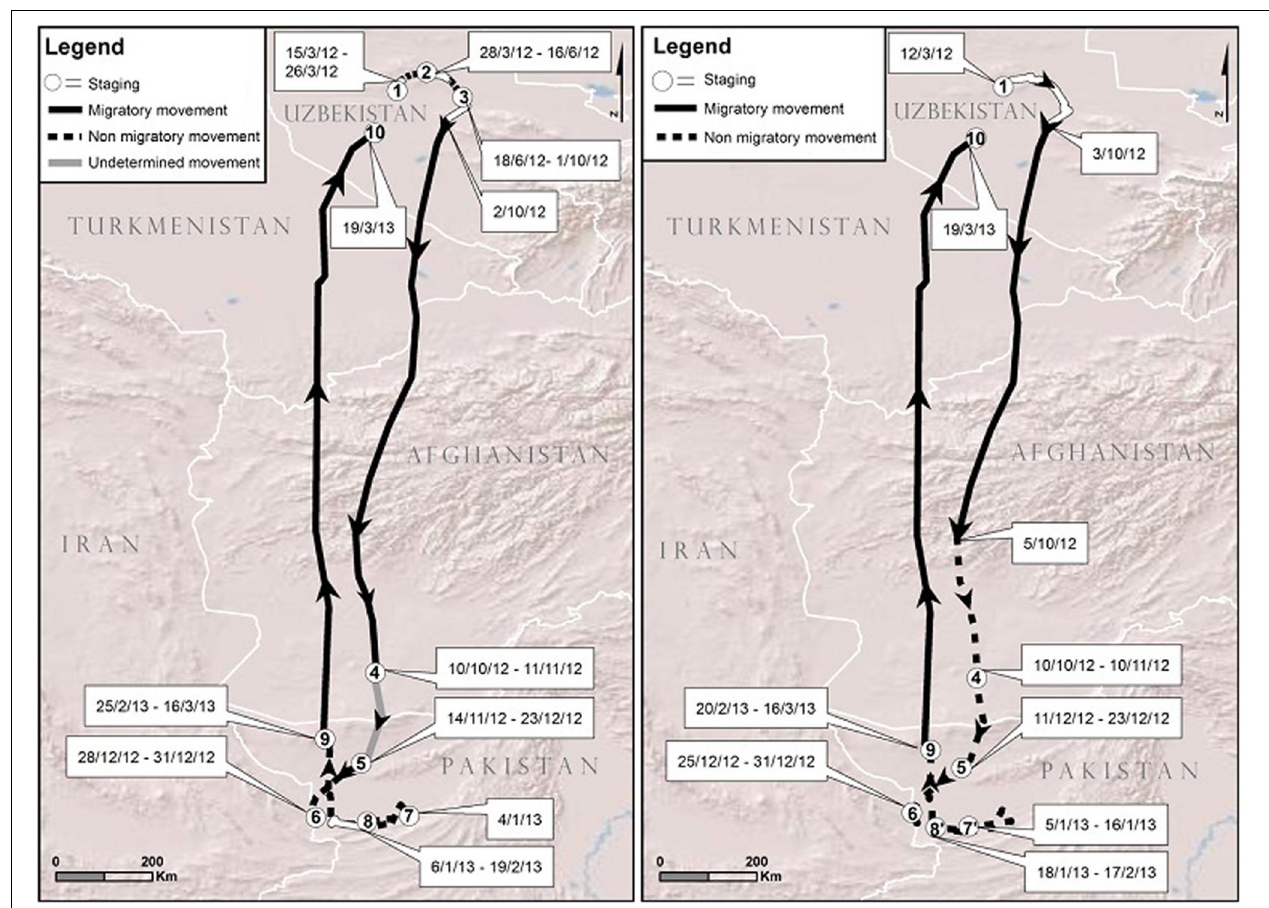
FIGURE 3 | Movement patterns for bird 5863 in 2012–2013 with staging sites (white areas), migration legs (solid lines) and non-migratory movements (dashed lines) estimated: 1- with the visual analysis (left) and 2- with the PELT-TREE method (right).